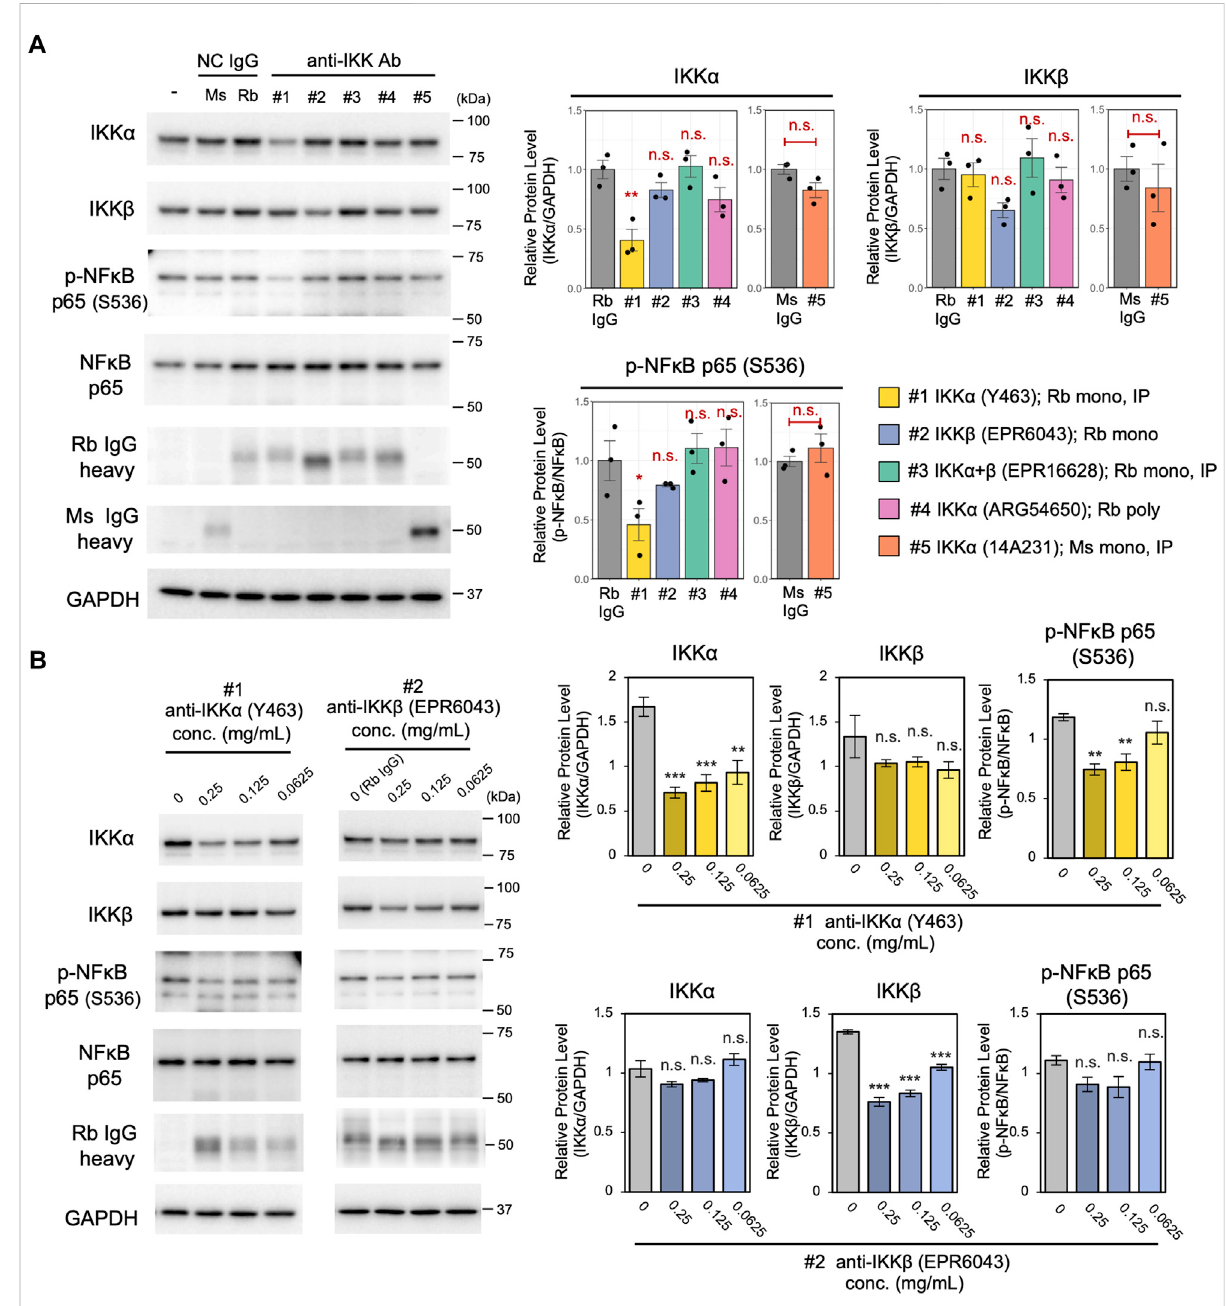
FIGURE 4 Screening of fi ve different anti-IKK antibodies using the cell resealing technique. (A) TRIM21-overexpressed Piranha TM HEK293T cells were resealed with 0.125 mg/ml of the respective anti-IKK antibodies and incubated for 3 h, and the ef fi ciency and speci fi city of IKK degradation was tested by quantifying the degradation of IKK α and IKK β using western blotting. Of the fi ve tested antibodies, one anti-IKK α – speci fi c antibody (clone Y463) signi fi cantly reduced IKK α levels. Although its effects were not signi fi cant, one anti-IKK β – speci fi c antibody (clone EPR6043) tended to reduce IKK β levels. Data are expressed as the mean ± SEM ( n = 3). For the four rabbit anti-IKK antibodies, the statistical signi fi cance of differences compared with the control (normal rabbit IgG) was assessed using Dunnett ’ s test as a multiple comparison test. For the single mouse anti-IKK antibody,Welch ’ st-testwasusedtodetectthedifferencecomparedwiththecontrol(normalmouseIgG).Rb:rabbit,Ms:mouse. (B) Concentration- dependent degradation ability of the two anti-IKK antibodies. The IKK α -speci fi c antibody (clone Y463) degraded IKK α more ef fi ciently than IKK β